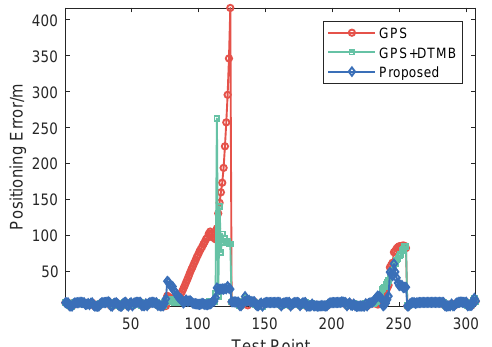
Figure 21. Positioning error at each test point at Site